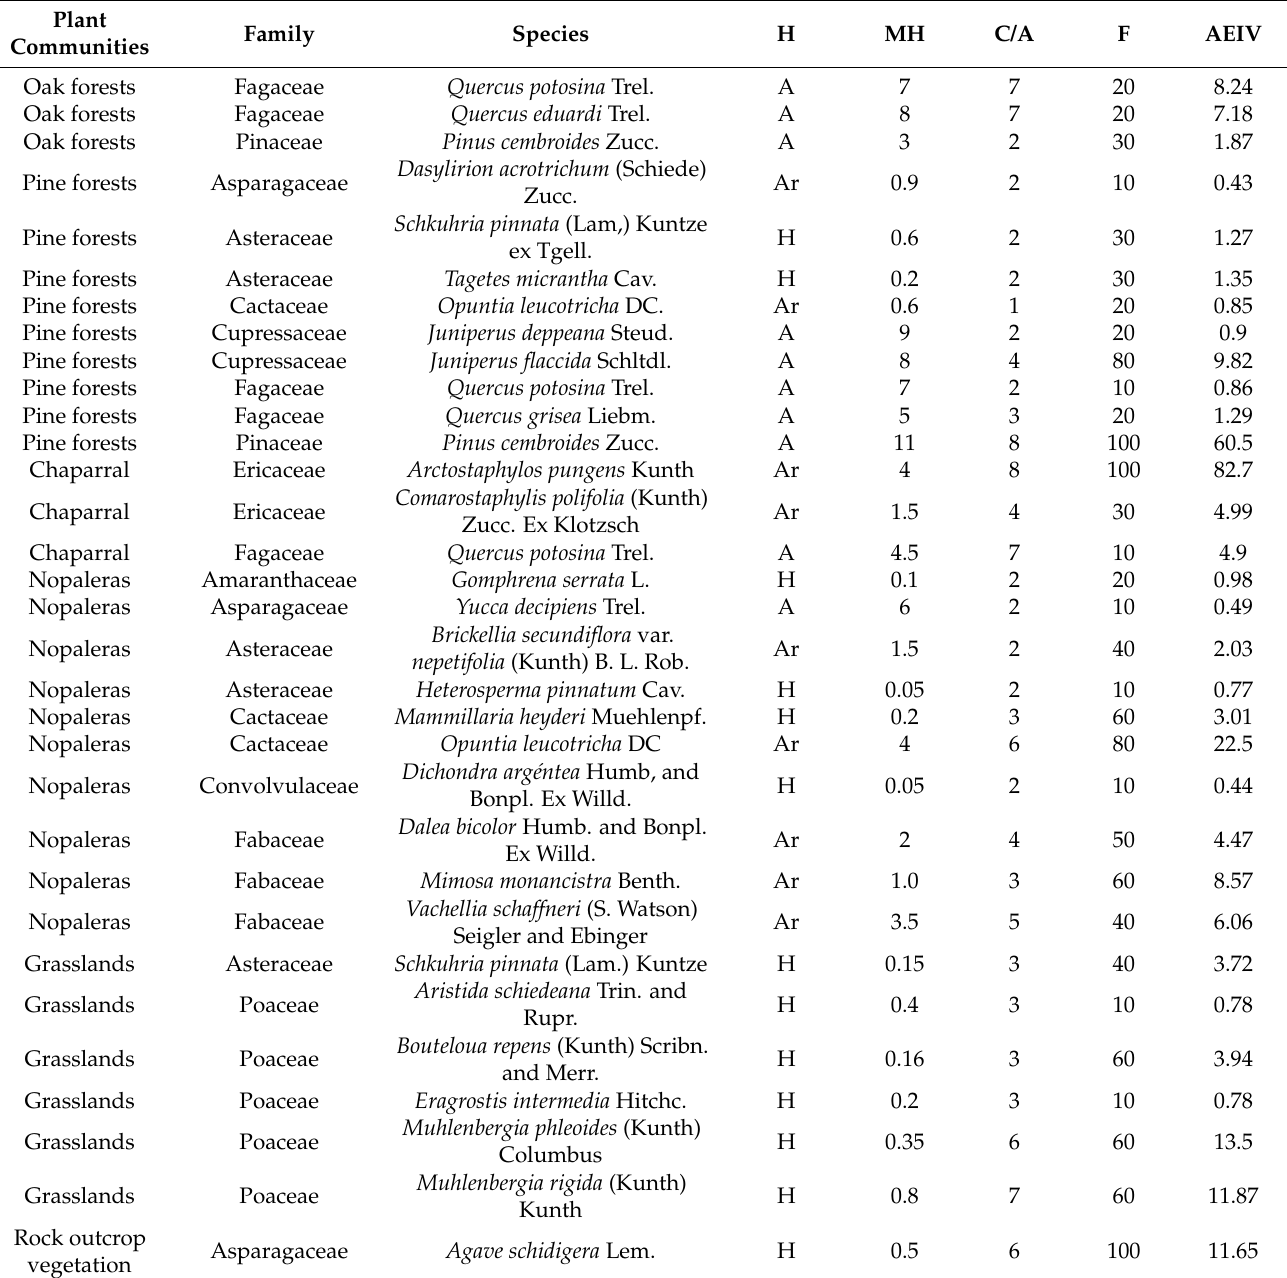
Table 3. Main structural species by plant community reported by Guzm á n and Vela-G á lvez [44], Miranda and Hern á ndez- X [43], Enriquez-Enriquez et al. [45], Rzedowski [11] and Gonz á lez-Elizondo et al. [46], and registered in the Sierra de los Cardos, Susticac á n, Zacatecas. H = habit (A = tree; H = herb; Ar = shrub); MH = maximum height of the species in meters per community; C/A = coverage–abundance according to the Braun–Blanquet values modified by van der Marel